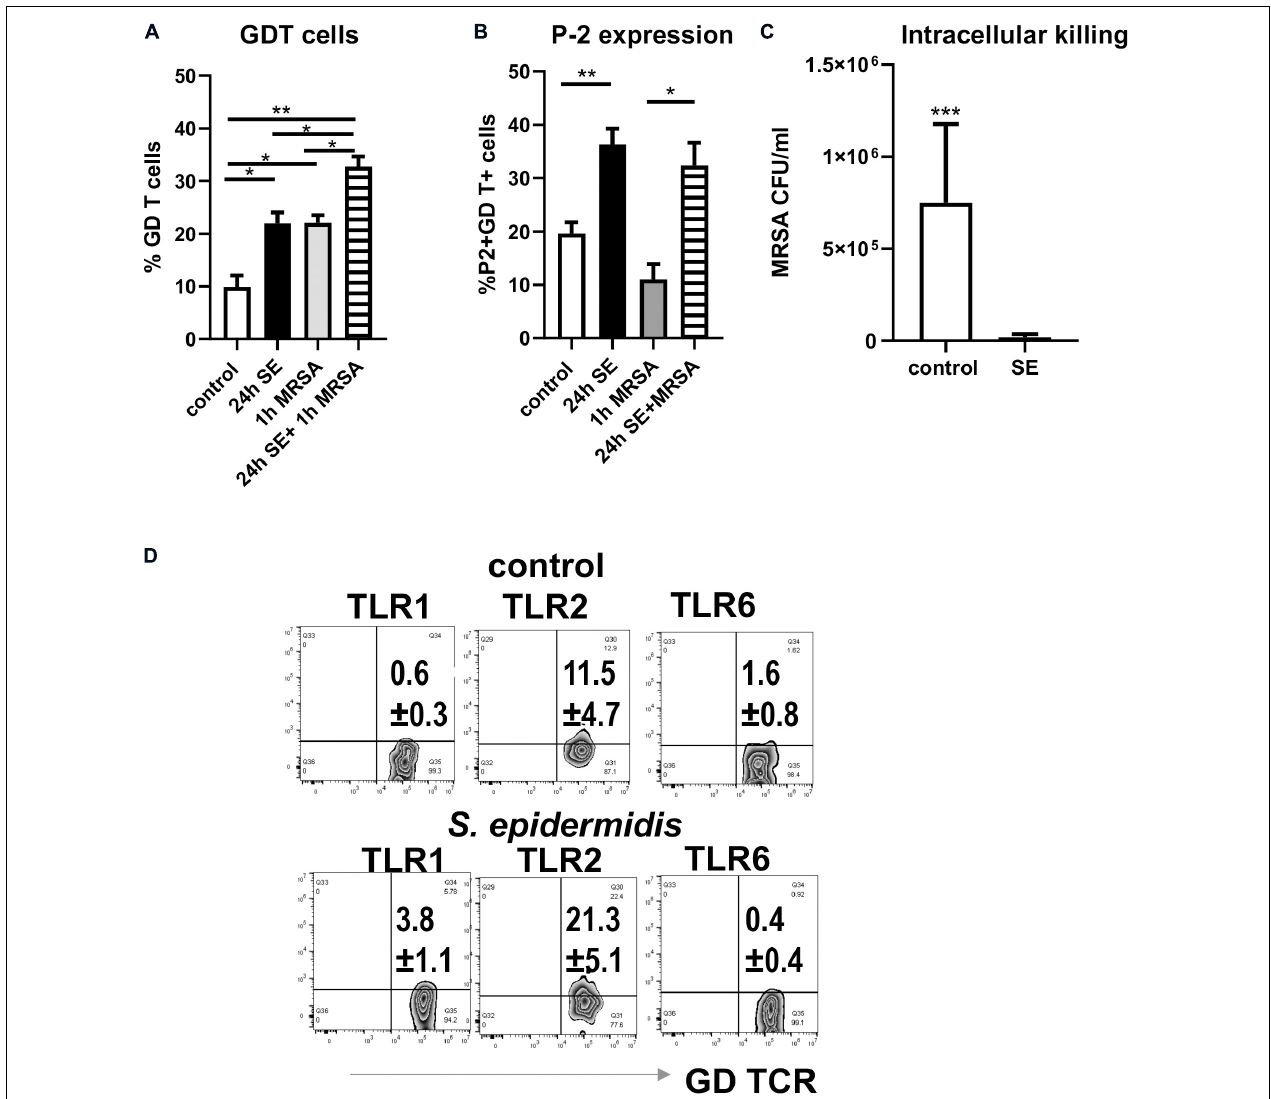
FIGURE 6 | Pre-treatment of skin cells with Staphylococcus epidermidis increases frequency of GD T cells, stimulates P-2 expression, and limits survival of intracellular MRSA. Single skin cells were exposed to S. epidermidis at MOI 1:20 or media control for 24 h. After washing to remove S. epidermidis , cells were infected with MRSA (MOI 1:20) for 1 h to allow intracellular infection, and extracellular bacteria were subsequently removed by gentamicin treatment. (A) Frequency of GDT cells and (B) P2 mRNA expression in CD45+ CD3+ GD TCR+ cells as determined by FISH-Flow ( n = 3 biological replicates). (C) Bar graph showing the number of intracellular MRSA (CFU/ml) upon hypotonic lysis of control and S. epidermidis pre-treated cells ( n = 3 biological replicates). (D) Expression of TLR1, TLR2, and TLR6 on gated CD45 + CD3 + TCR GD + T cells. Data represent at least two experiments with three independent biological replicates per group. * p < 0.05, ** p < 0.01 as calculated using two-way ANOVA with Holm-Sidak multiple-comparison (A) and *** p < 0.001 as calculated using Student t -test (B)